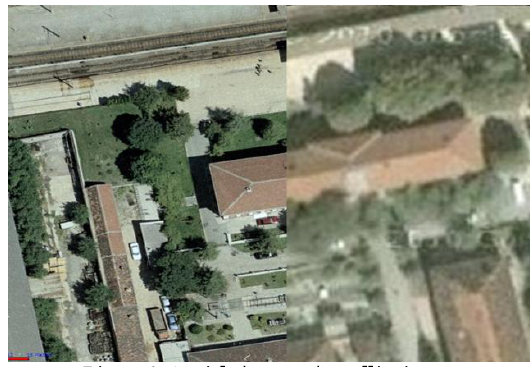
Figure 6. Aerial photo and satellite image